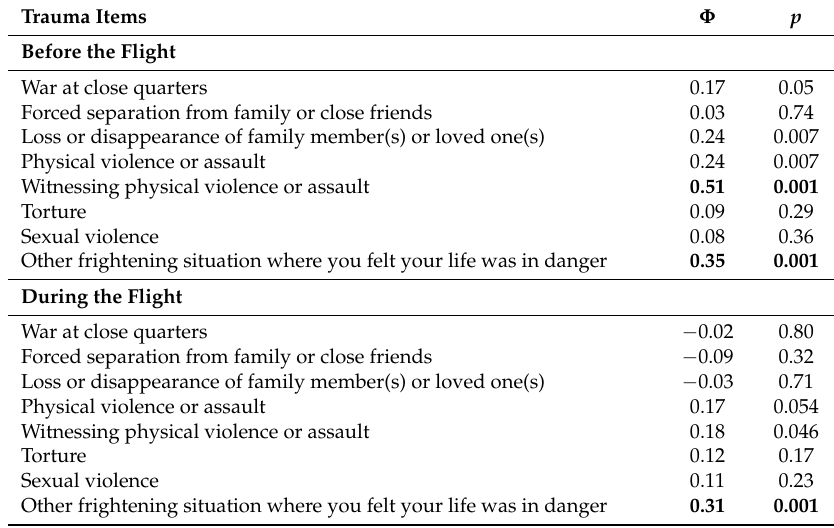
Table 2. Binominal correlation coefficients Φ and corresponding p -values of the items of RTHC with the SGTI as key